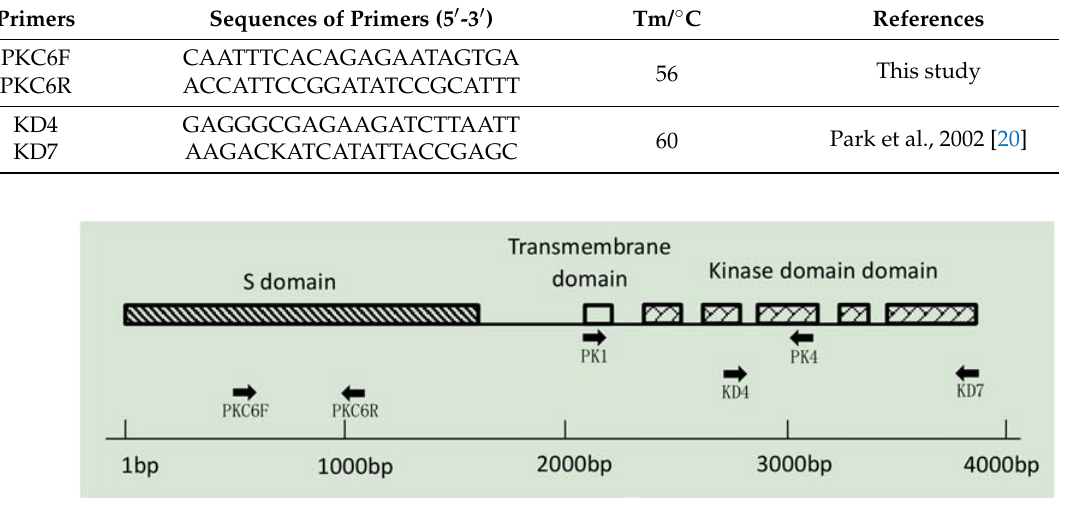
Figure 12. Schematic diagram of SRK gene structure and marker development